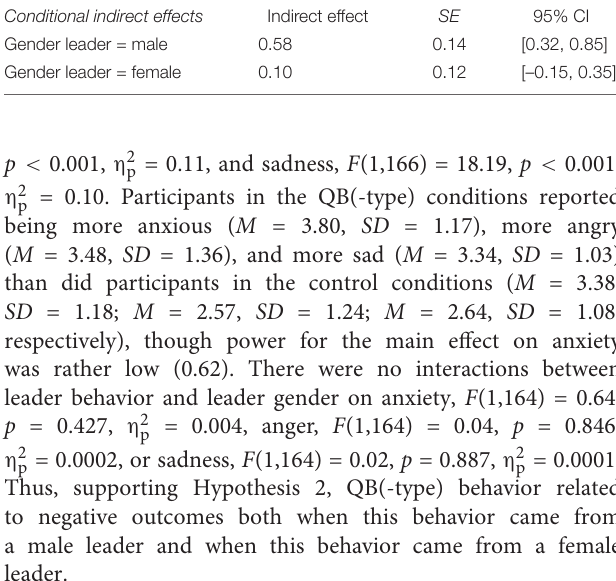
Frontiers in Psychology |